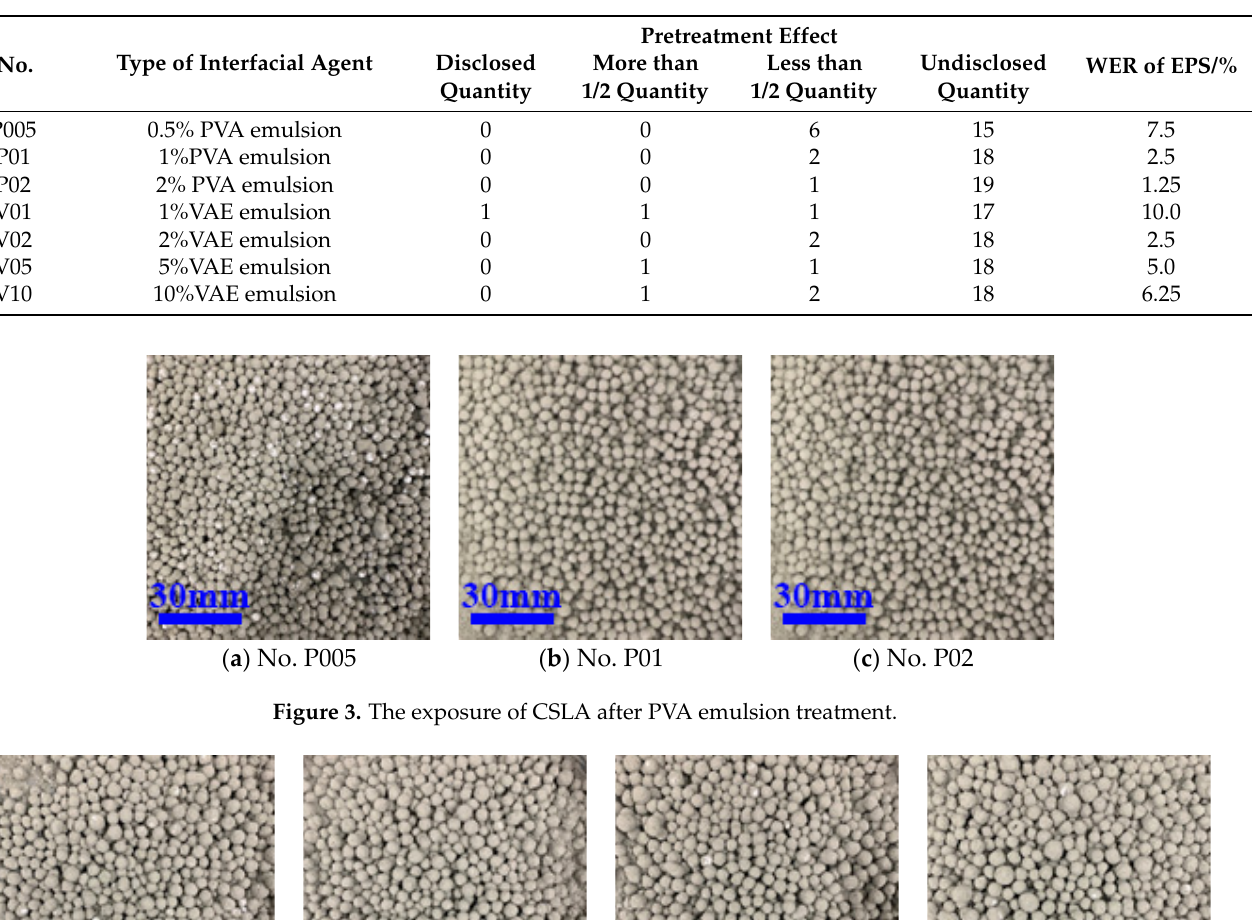
Table 4. Effect of organic emulsion on the WER of CSLA.